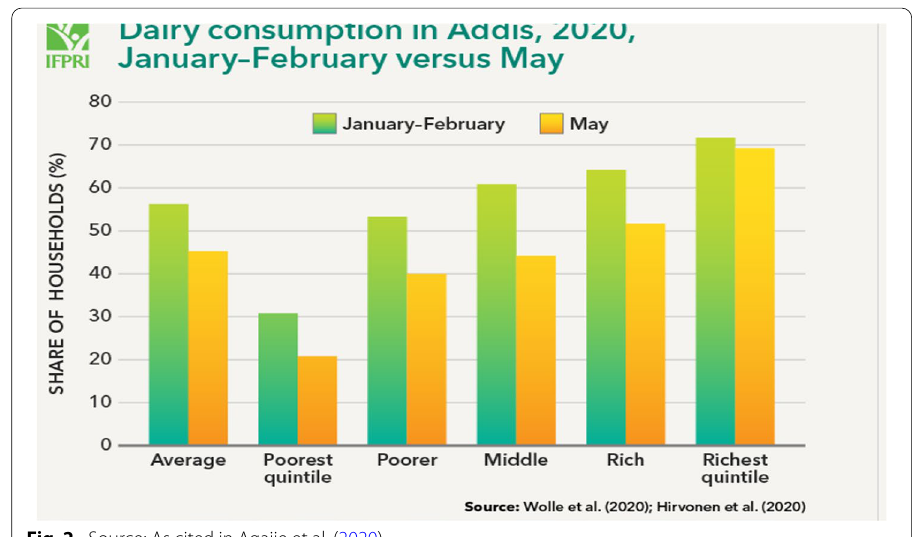
Fig. 2 Source: As cited in Agajie et al.